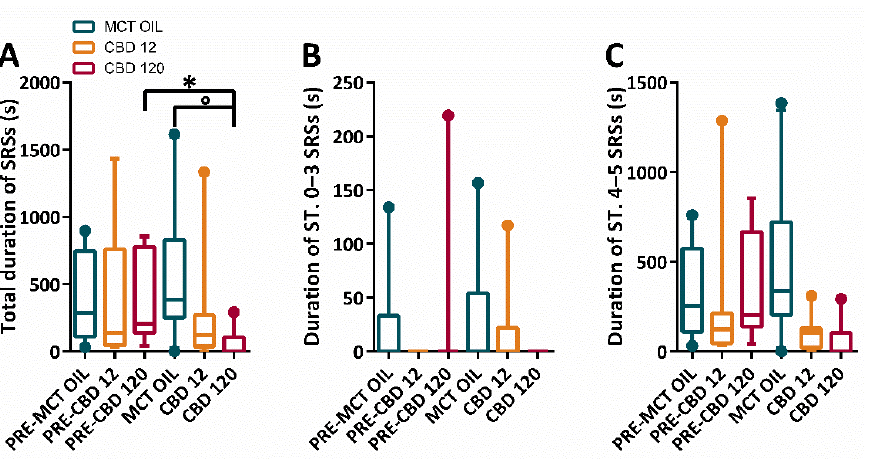
Figure 3. Duration of spontaneous recurrent seizures (SRSs) in epileptic rats treated with cannabidiol (CBD) at 12 mg/kg, 120 mg/kg or with medium-chain triglyceride (MCT) oil. Rats (n = 30) were treated with CBD 12 mg/kg (n = 10, 2 of which did not display SRSs and were attributed a 0 value), CBD 120 mg/kg (n = 10, 5 of which did not display SRSs and were attributed a 0 value), or MCT oil (n = 10, 1 of which did not display SRSs and were attributed a 0 value). In ( A ), CBD at 120 mg/kg significantly decreased (Tukey test; * p < 0.05, PRE-CBD 120 vs. CBD 120; ◦ p < 0.05, MCT OIL vs. CBD 120) the total number of SRSs. The high dose of CBD displayed no significant effects when stages (ST.) 0–3 ( B ) and ST. 4–5 ( C ) SRSs were considered separately.